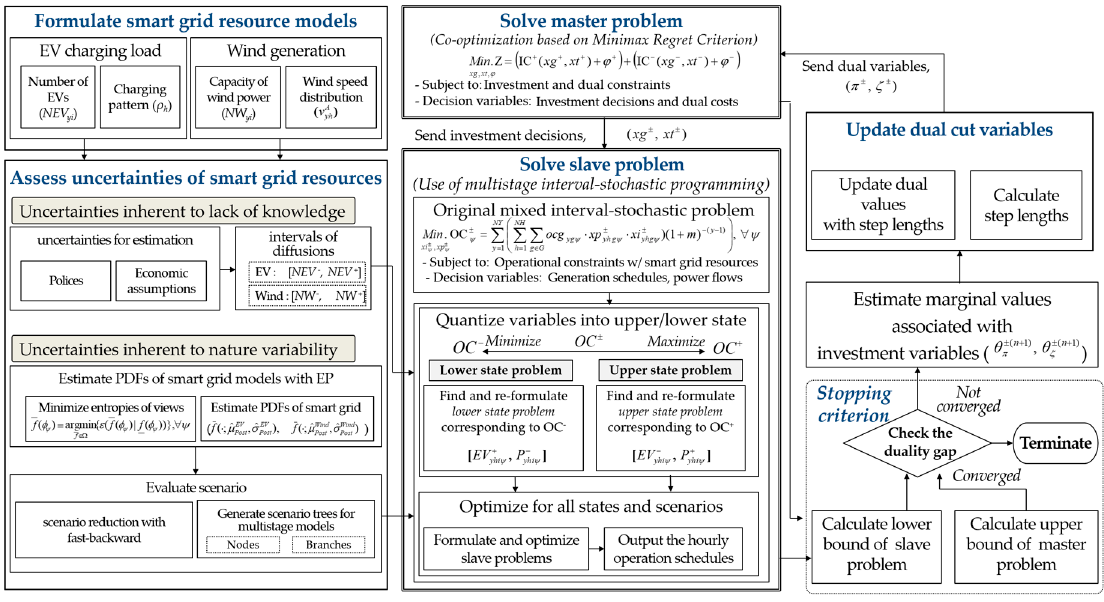
Figure 2. Framework of proposed method with smart grid resources.